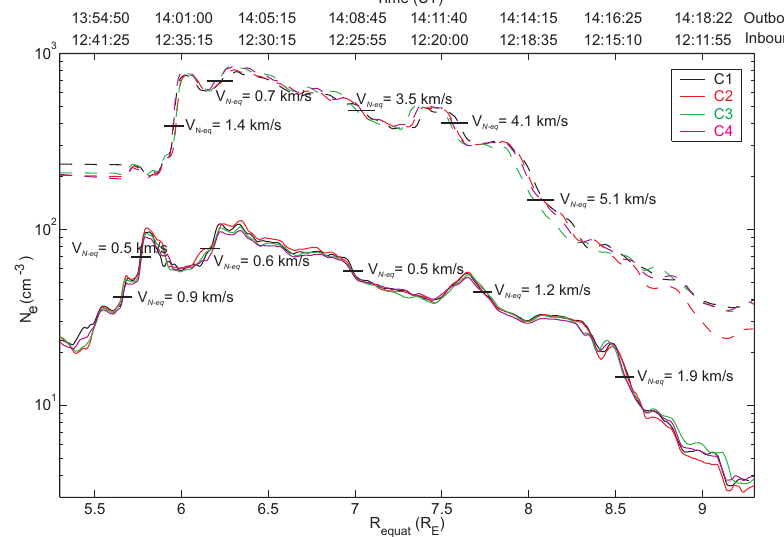
Fig. 9. Electron density profiles as a function of R equat for the two plume crossings on 2 June 2002 (time indicated as reference). The lower four curves correspond to the inbound pass and the upper four curves (shifted by a factor 10) to the outbound pass by the four CLUSTER satellites. The magnitude of the normal boundary velocity V N − eq derived from the time delays of different features during both plume crossings and projected onto the magnetic equatorial plane is indicated on the figure.